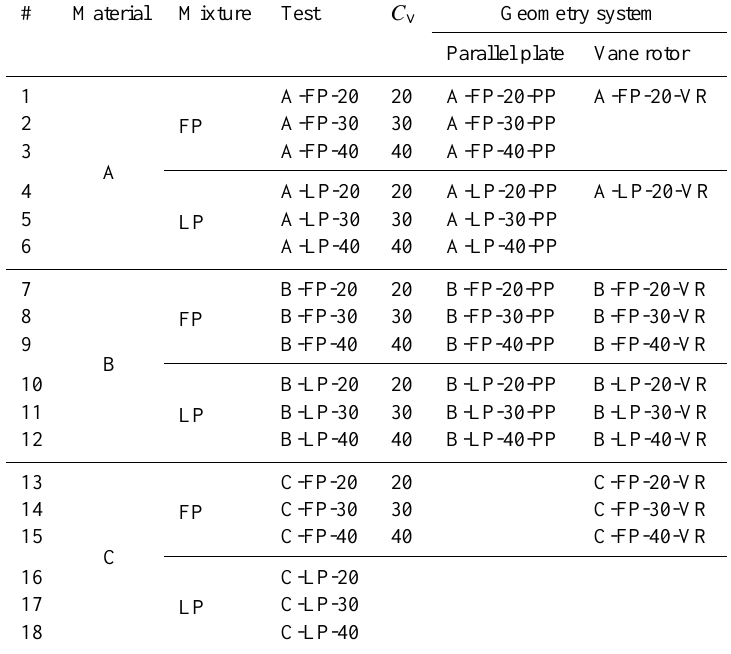
Table 2. Experimental